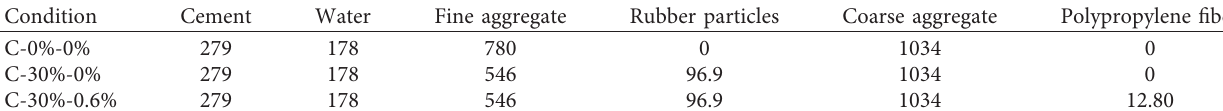
Table 1: Mix proportions of rubber fiber concrete (kg/m 3 ).